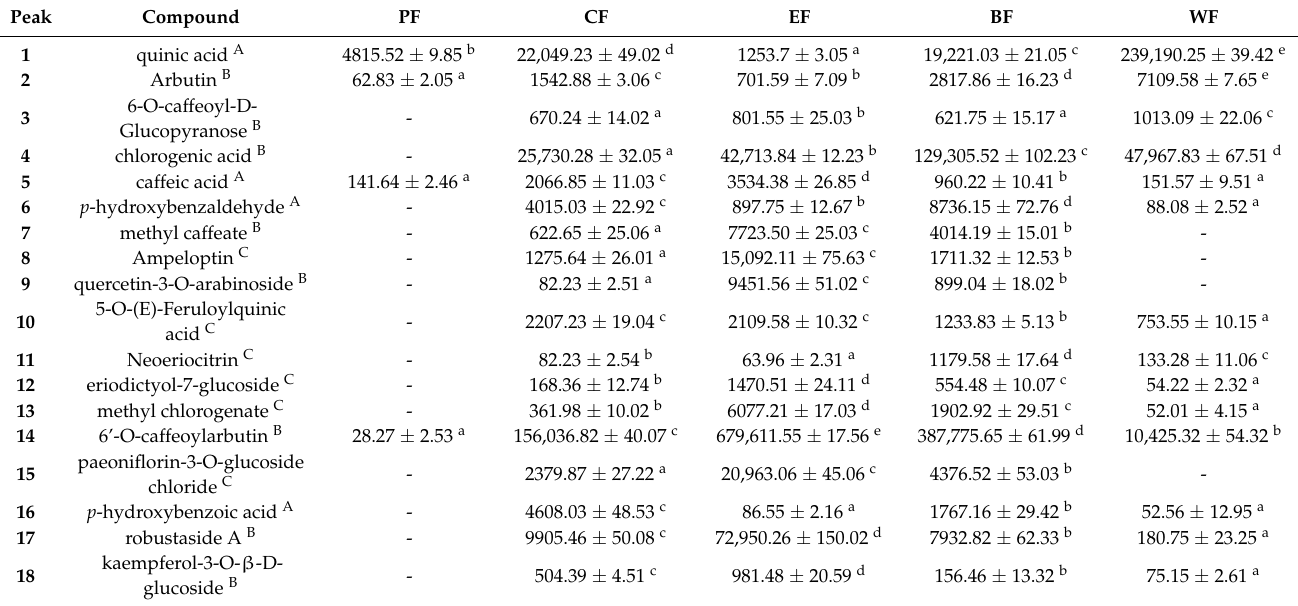
Table 3. Quantitative results of the identified and tentatively identified compounds in the five fractions from Vaccinium dunalianum by UHPLC- MS/MS ( µ g/g dry